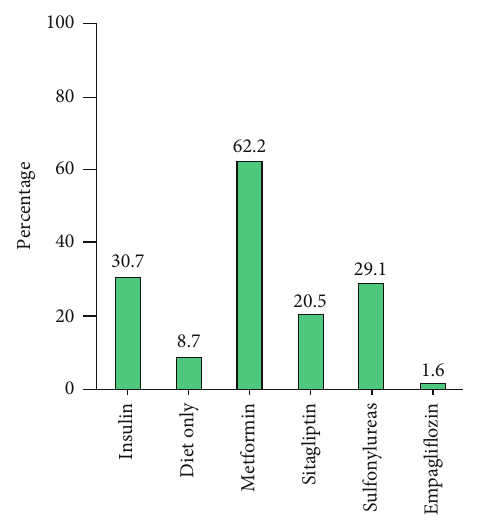
Figure 1: Medications used by patients for